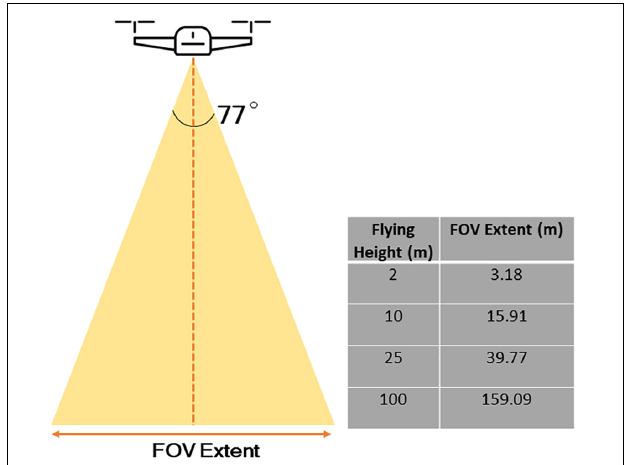
FIGURE 3 | The relationship between flying height and extent of image. As an example, the DJI Mavic 2 Pro, a relatively commonly used drone for capturing spatial information in scientific research, and the camera has a field of view of 77 ◦ and an image size in pixels of 5472 ×